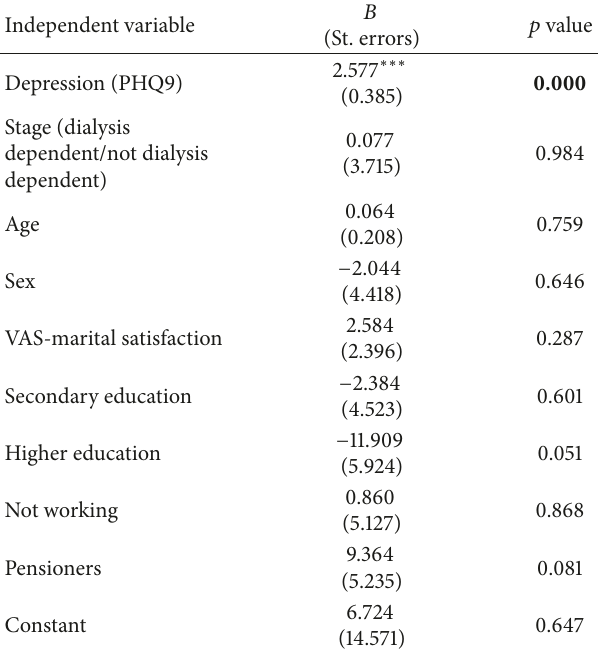
Table 4: Multiple linear regression analysis of spouse burden (dependent variable) to depression, stage of chronic kidney disease (dialysis dependent/not dialysis dependent), age, sex, marital satis- faction, education, and employment ( 𝑛 = 50